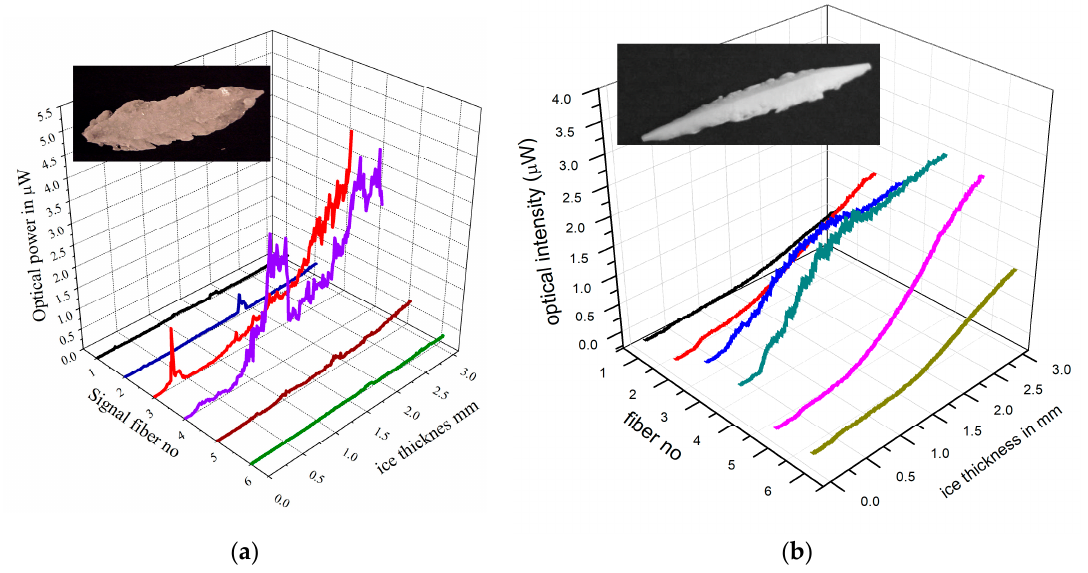
Figure 16. Optical measurements of ice thickness with flat polished fiber array sensor (LWC 0.5 mL/m 3 and 20 μ m water droplets) ( a ) glazed ice ( − 5 °C) ( b ) rime ice − 20 °C.